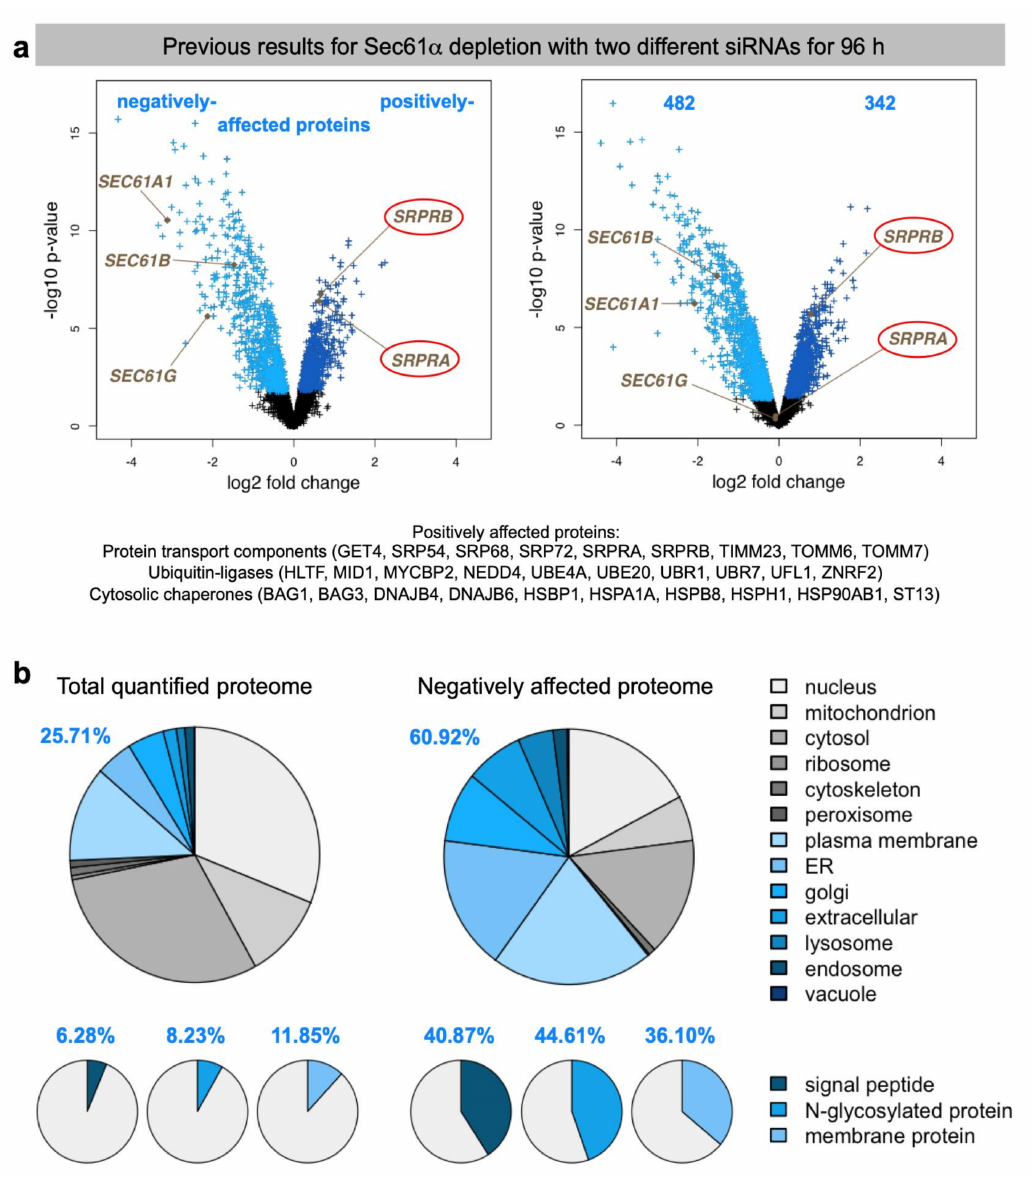
Figure 3. (on previous page) . Representative volcano plots and gene ontology (GO) enrichment after Sec61 depletion. ( a ) Differentially affected proteins were characterized by the mean difference of their intensities plotted against the respective permutation false discovery rate-adjusted p -values in volcano plots. The results for a single targeting siRNA are shown in each panel. Subunits of the Sec61 complex and of the SRP receptor are highlighted in the plots. In addition, the numbers of proteins, which were negatively or positively affected by both targeting siRNAs, are given in the right panel; the full set of relevant positively affected proteins are given below the plots. ( b ) Classification of Sec61 clients was based on GO enrichment factors where the results from the complete set of quantified proteins in the left panel are compared with the negatively affected proteome. Protein annotations of signal peptides, membrane location, and N-glycosylation in humans were extracted from UniProtKB, and used to determine the enrichment of GO annotations among the negatively affected proteins. The figure summarizes results from an experiment, which served as proof-of-principle for the approach and is shown here in modified form for comparison with the results on putative mRNA receptors